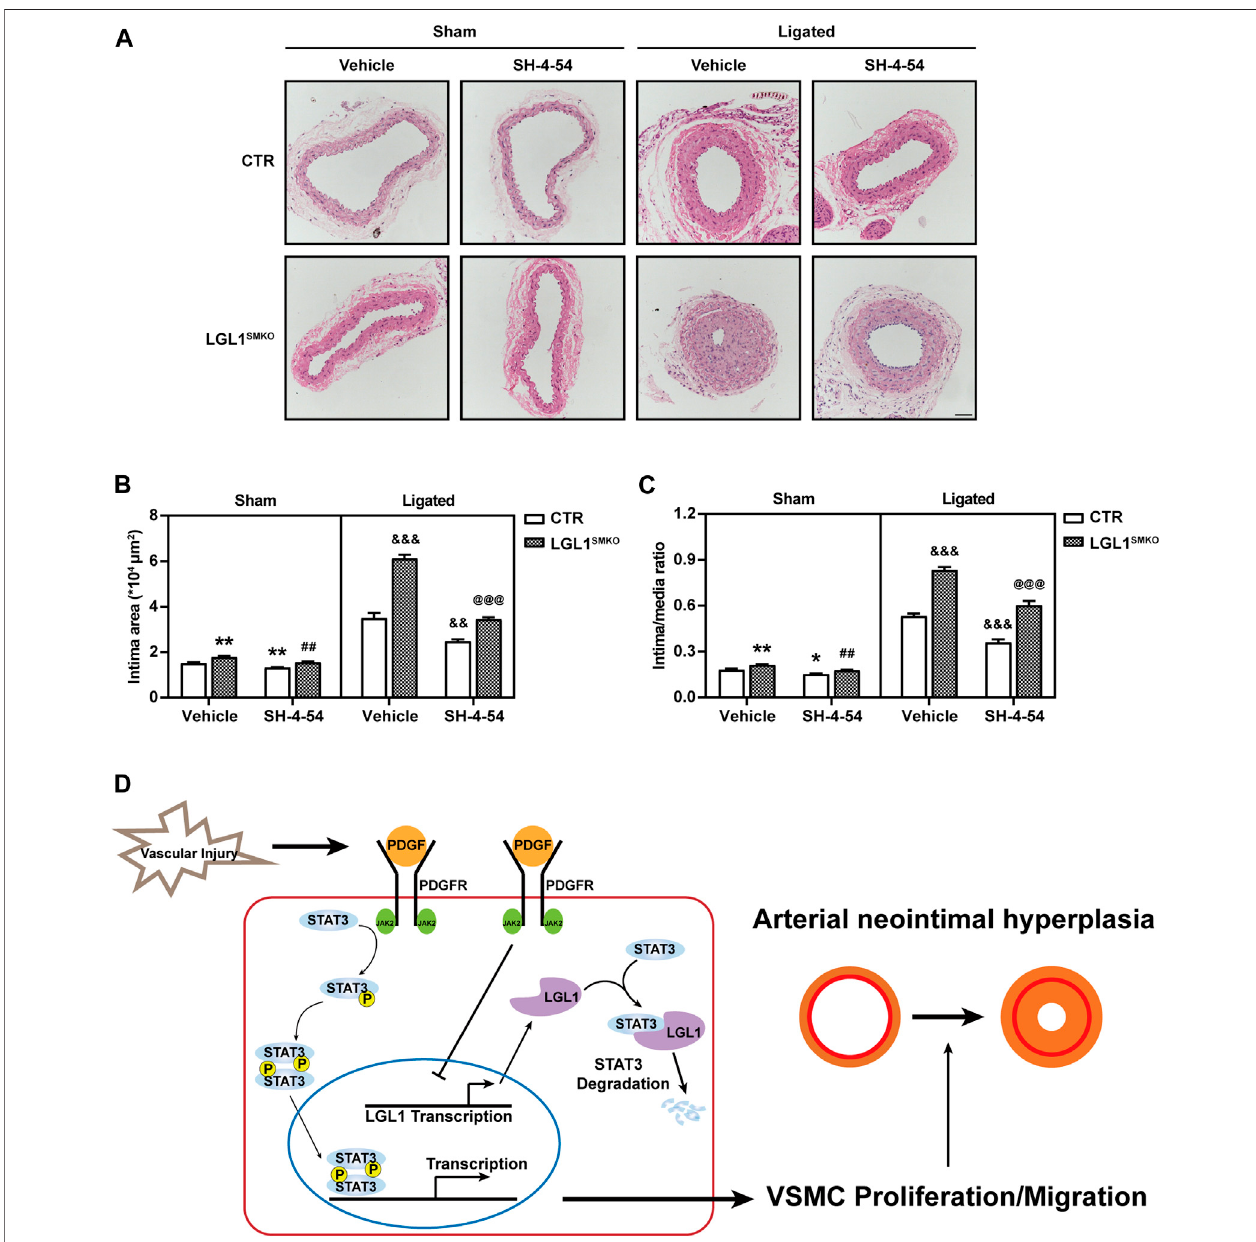
FIGURE 7 | STAT3 inhibitor attenuated neointimal hyperplasia in LGL1 SMKO mice. (A) CTR and LGL1 SMKO mice were administrated with STAT3 inhibitor SH-4-54 (10 mg/kg) daily and then underwent left CCA ligation for 21 days. Carotid arteries were stained with HE. (B,C) The intimal area (B) and intima/media ratio (C) were calculated ( n = 4). Scale bar: 50 μ m. * p < 0.05, ** p < 0.01 vs. CTR + Vehicle + Sham. ## p < 0.01 vs. LGL1 SMKO + Vehicle + Sham. && p < 0.01, &&& p < 0.001 vs. CTR + Vehicle + Ligated. @@@ p < 0.001 vs. LGL1 SMKO + Vehicle + Ligated. (D) Schematic diagram of neointimal hyperplasia inhibition by LGL1 via STAT3